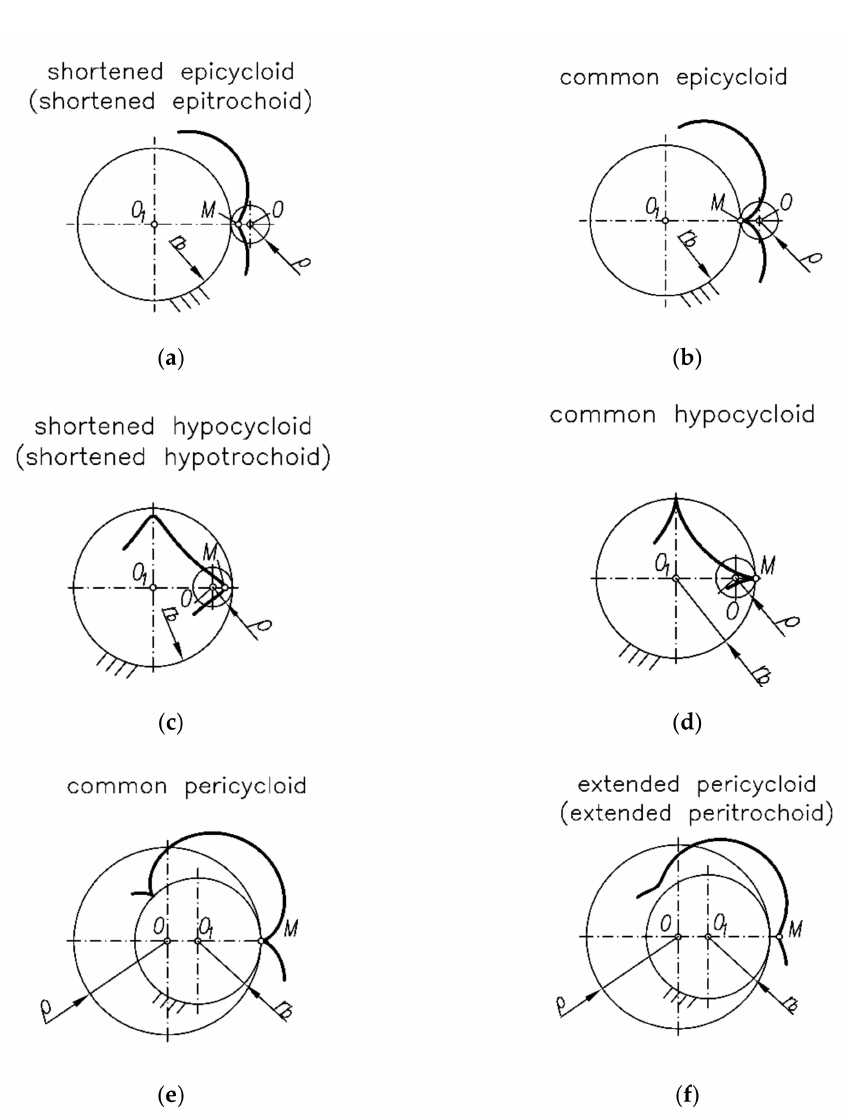
Figure 2. Family of cycloidal curves: ( a ) shortened epicycloid (shortened epitrochoid), ( b ) com- mon epicycloid, ( c ) shortened hypocycloid (shortened hypotrochoid), ( d ) common hypocycloid, ( e ) common pericycloid and ( f ) extended pericycloid (extended